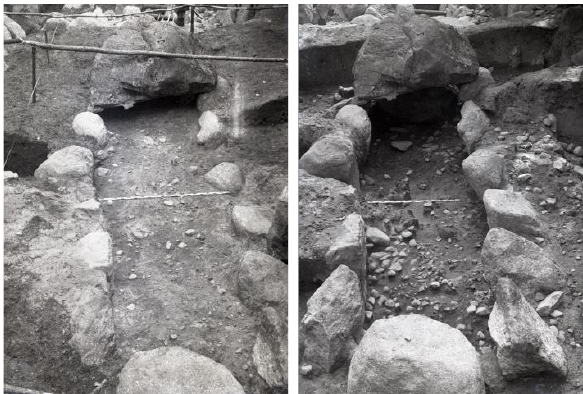
Figure 3: Digitized photo of the excavation (left), same scene at a later stage